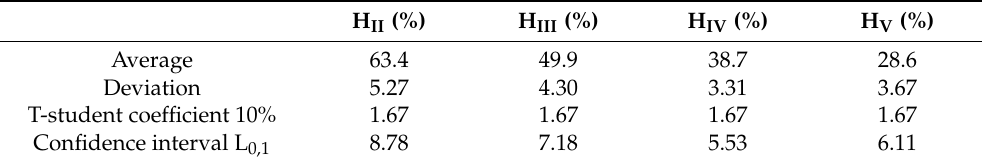
Table 6. Pulse heights on the flaw detector screen—determination of measurement errors in the defect area (the complete set of results are available in the Appendix A, Table A2).